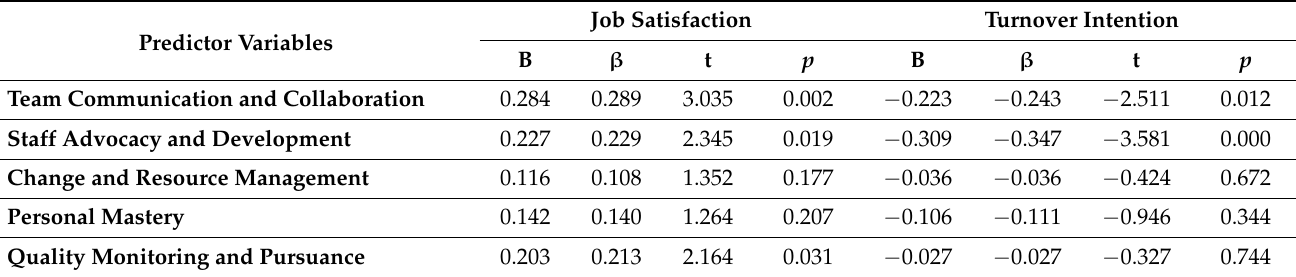
Table 5. Predictors of staff nurses’ job satisfaction and turnover